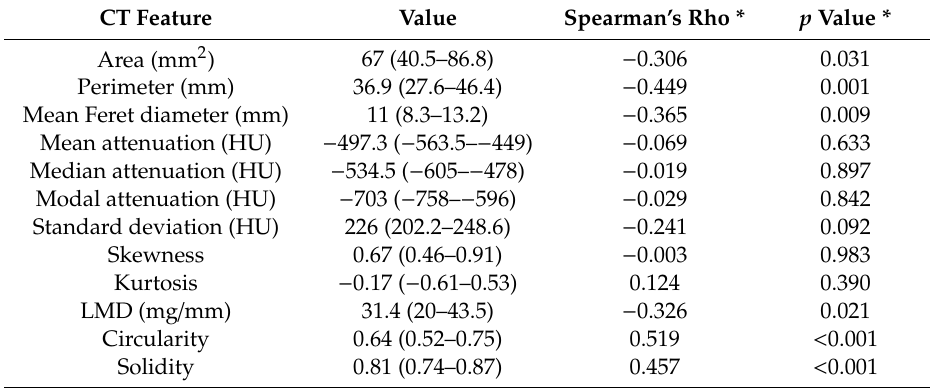
Table 2. Quantitative CT features calculated from the baseline CT images of all part-solid